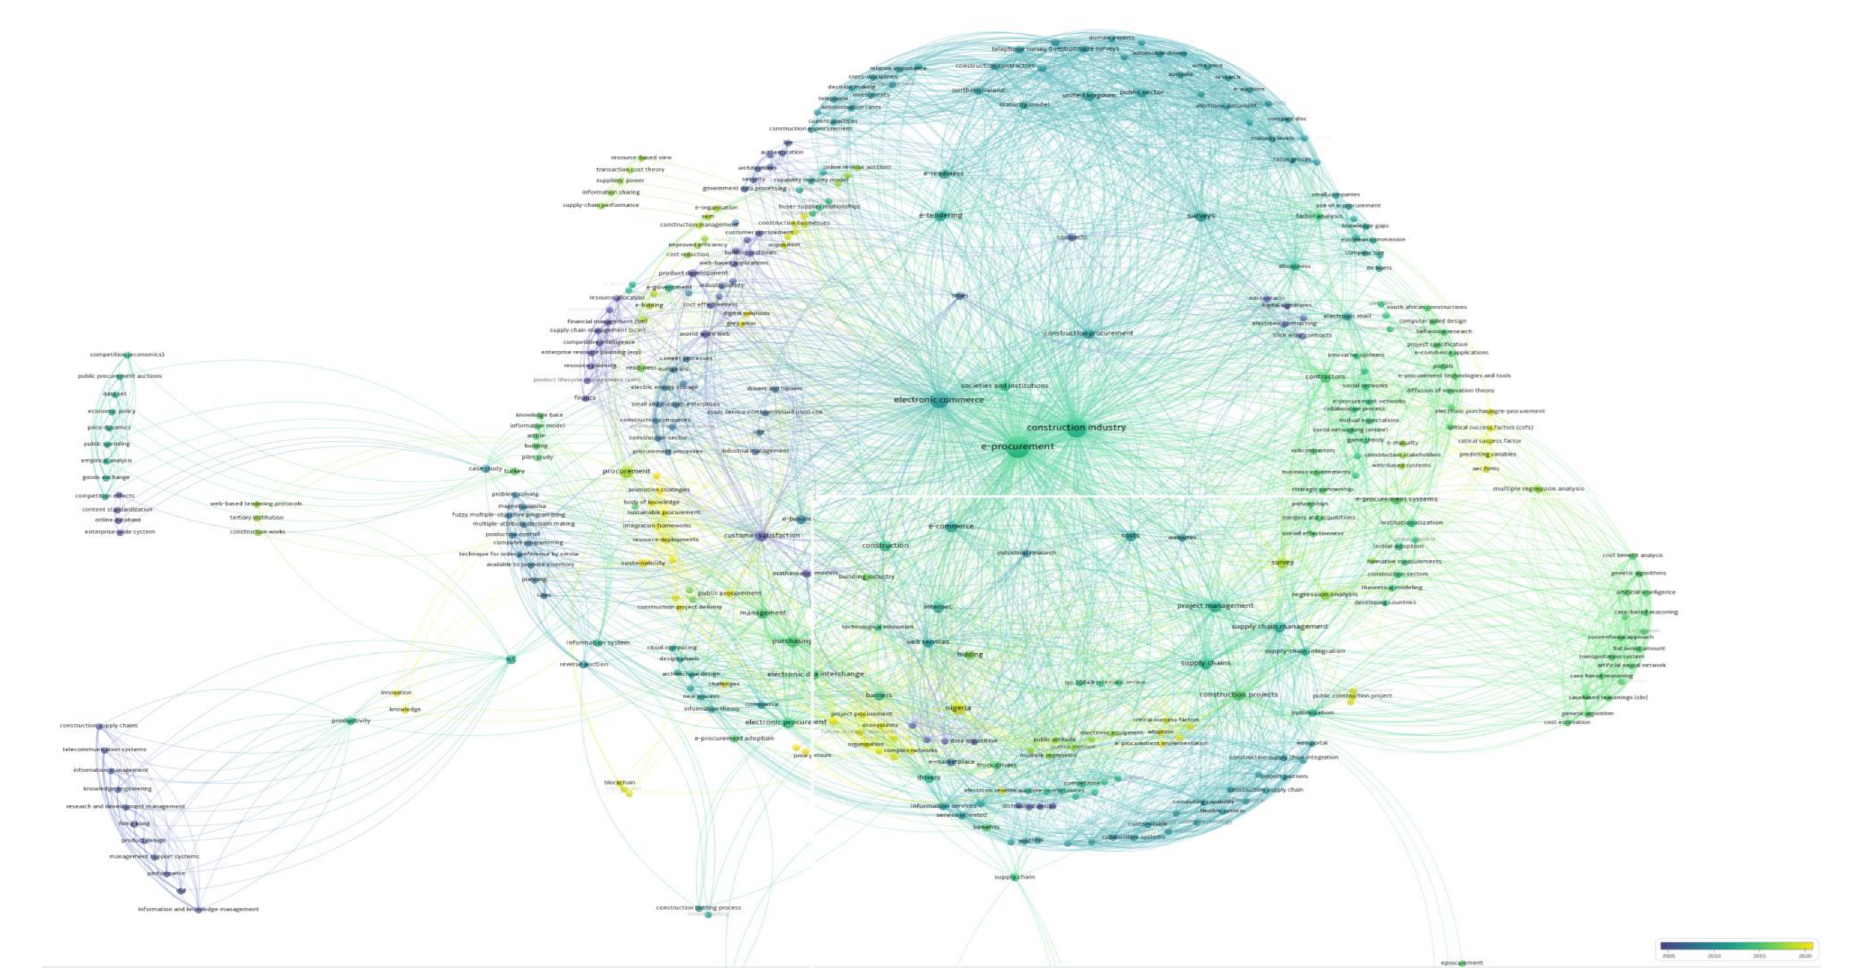
Figure 3. Network illustration of leading constructs of EP research; Source: authors’ computation. Note: Please, zoom in for higher resolution and better